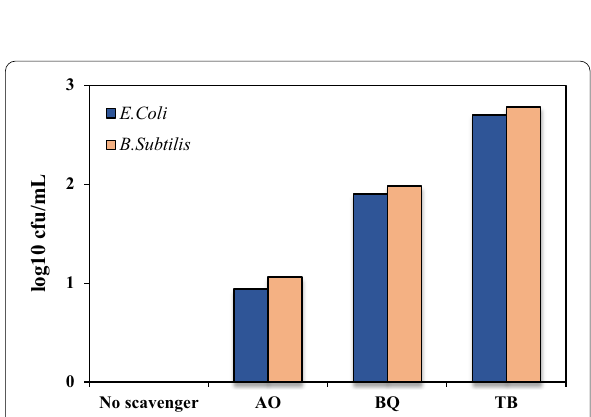
Fig. 6 Effect of the presence of scavenger on inactivation of E. coli and B. subtilis under the